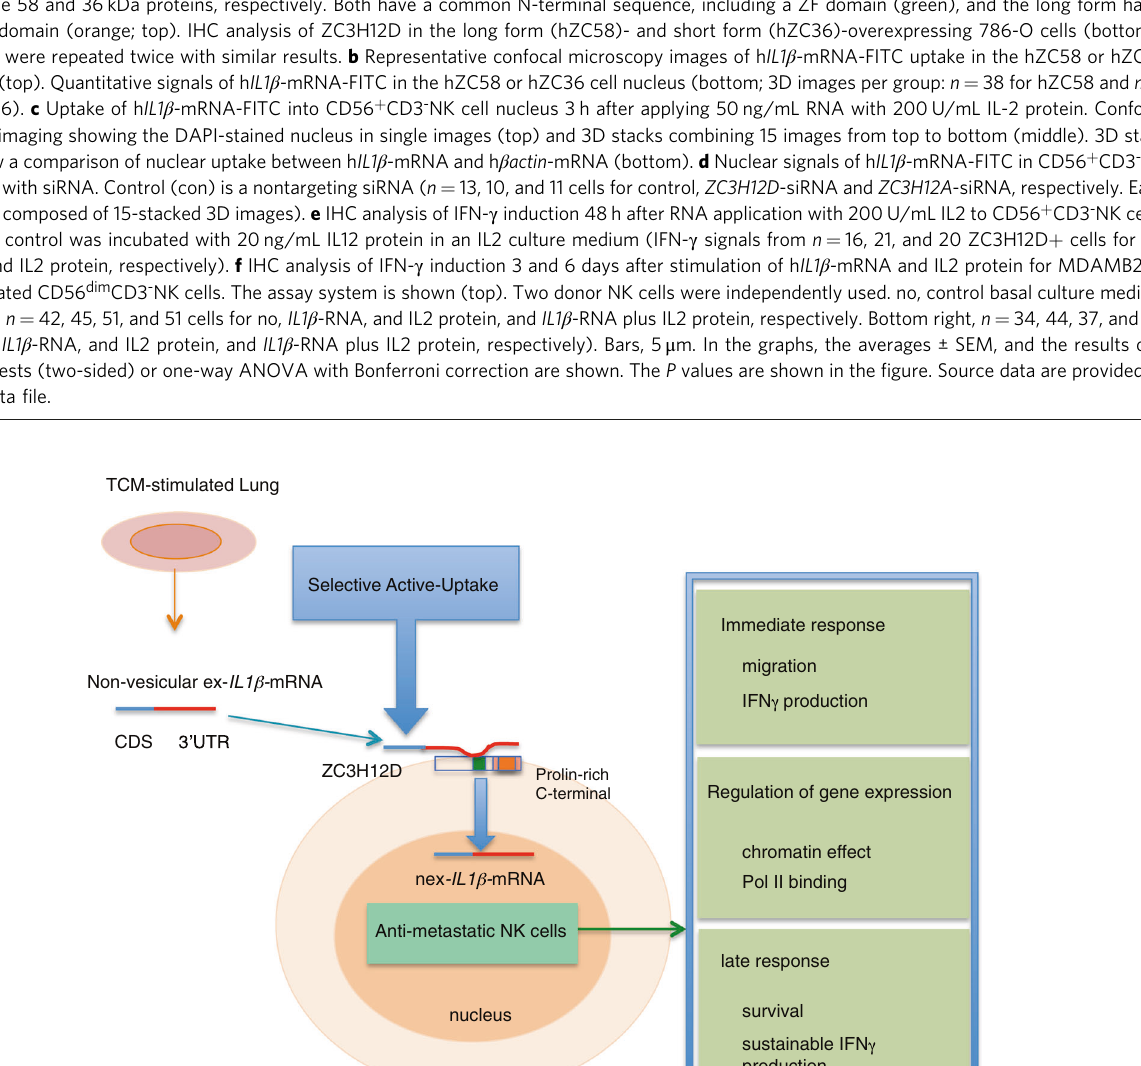
Fig. 7 hZC3H12D contributes to the uptake of nex-h IL1 β - mRNA with function. a Scheme for two splicing isoforms of hZC3H12D. The long and short forms encode 58 and 36 kDa proteins, respectively. Both have a common N-terminal sequence, including a ZF domain (green), and the long form has a proline-rich domain (orange; top). IHC analysis of ZC3H12D in the long form (hZC58)- and short form (hZC36)-overexpressing 786-O cells (bottom). Experiments were repeated twice with similar results. b Representative confocal microscopy images of h IL1 β - mRNA - FITC uptake in the hZC58 or hZC36